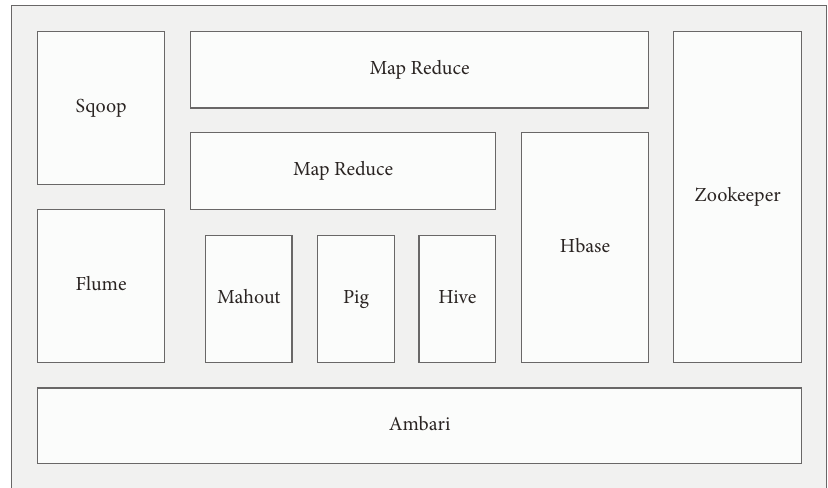
Figure 4: Hadoop